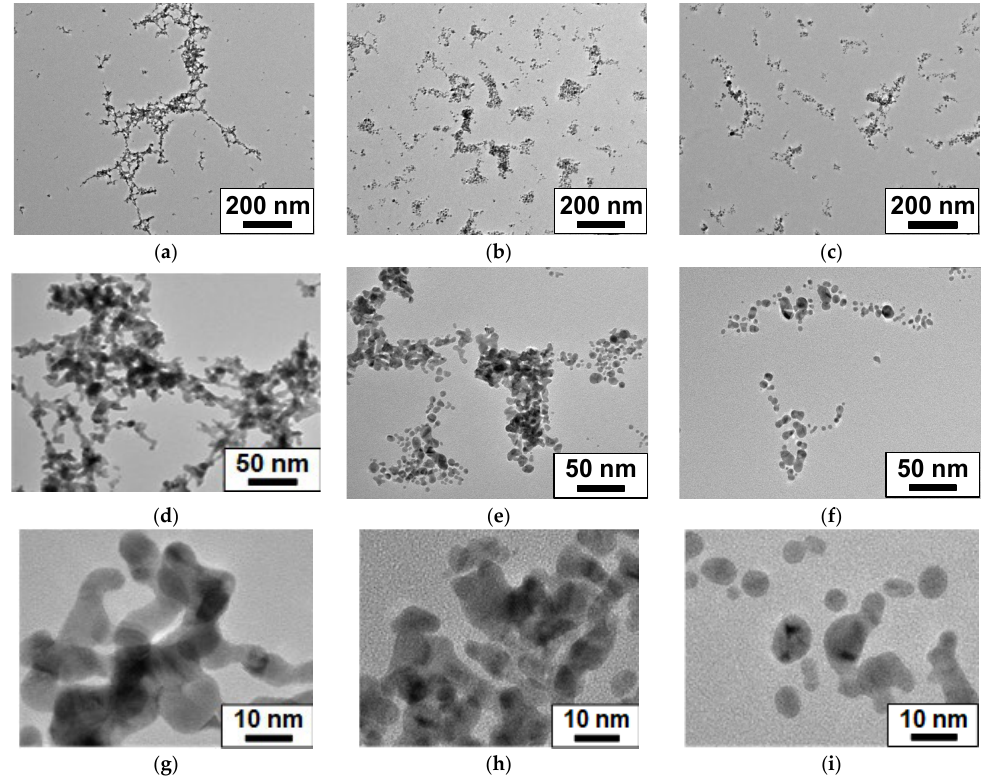
Figure 3. TEM images of Au nanoparticles obtained by spark discharge in chamber with gas temperatures of 24 °C ( a , d , g ) , −111 °C ( b , e , h ) , and −183 °C ( c ,f, i ).